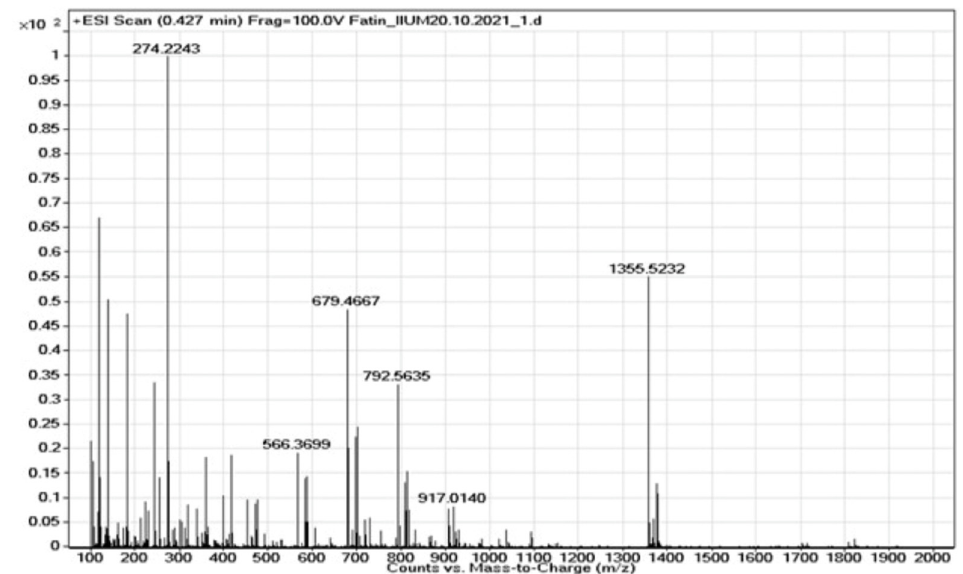
Figure 7. Mass spectrum of CN-Cbl in the purified oven-dried U. lactuca extract.